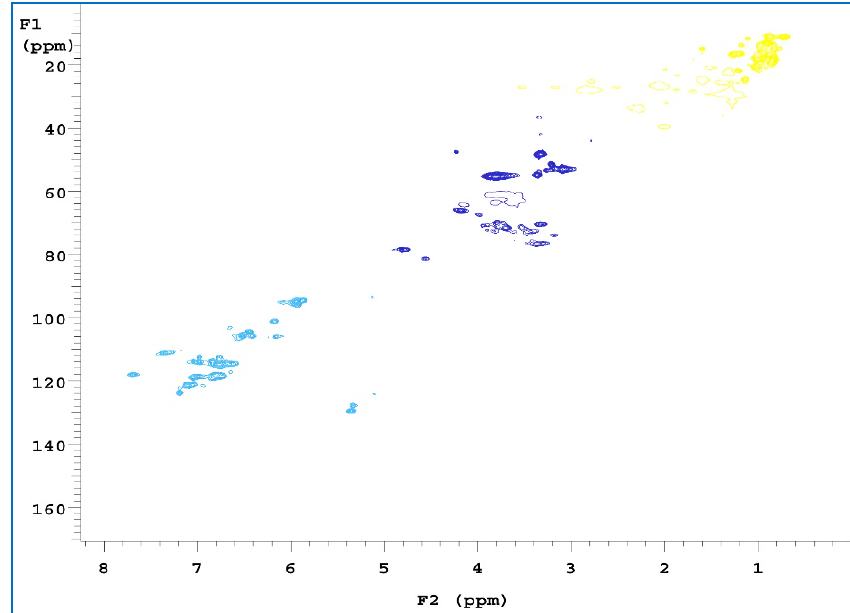
Figure 8. 2D-HSQC NMR spectra of RPB methanol extract.